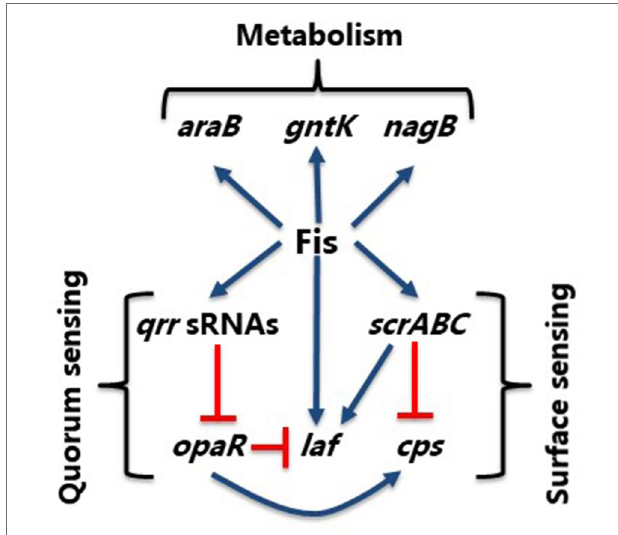
FIGURE 12 | Model of Fis integration of QS and surface sensing pathways. Model shows control of swarming ( laf ) and CPS ( cps ) production in V. parahaemolyticus . Blue arrows show positive regulation and orange hammers show negative